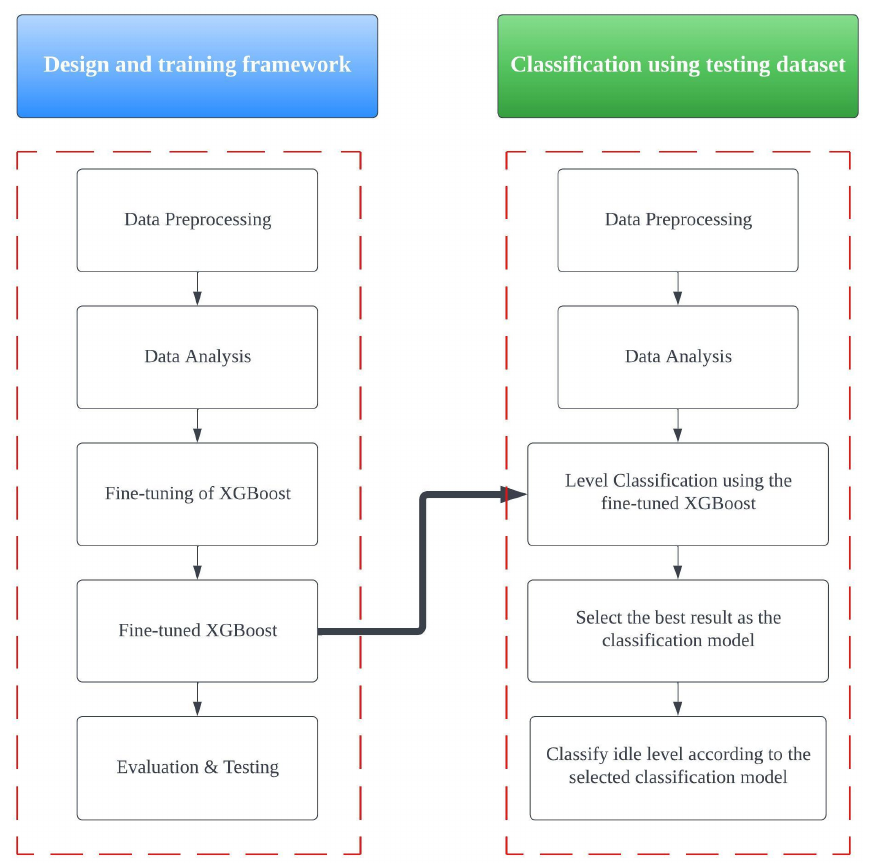
Figure 1. The two-stage data-driven framework.